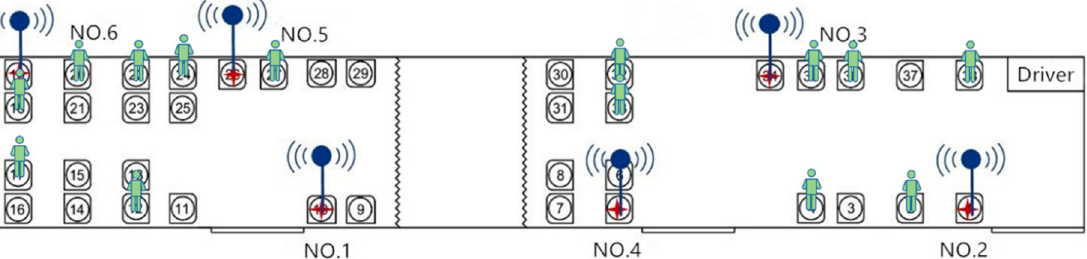
Figure 2. The location of the Wi-Fi probes and volunteers in the bus.